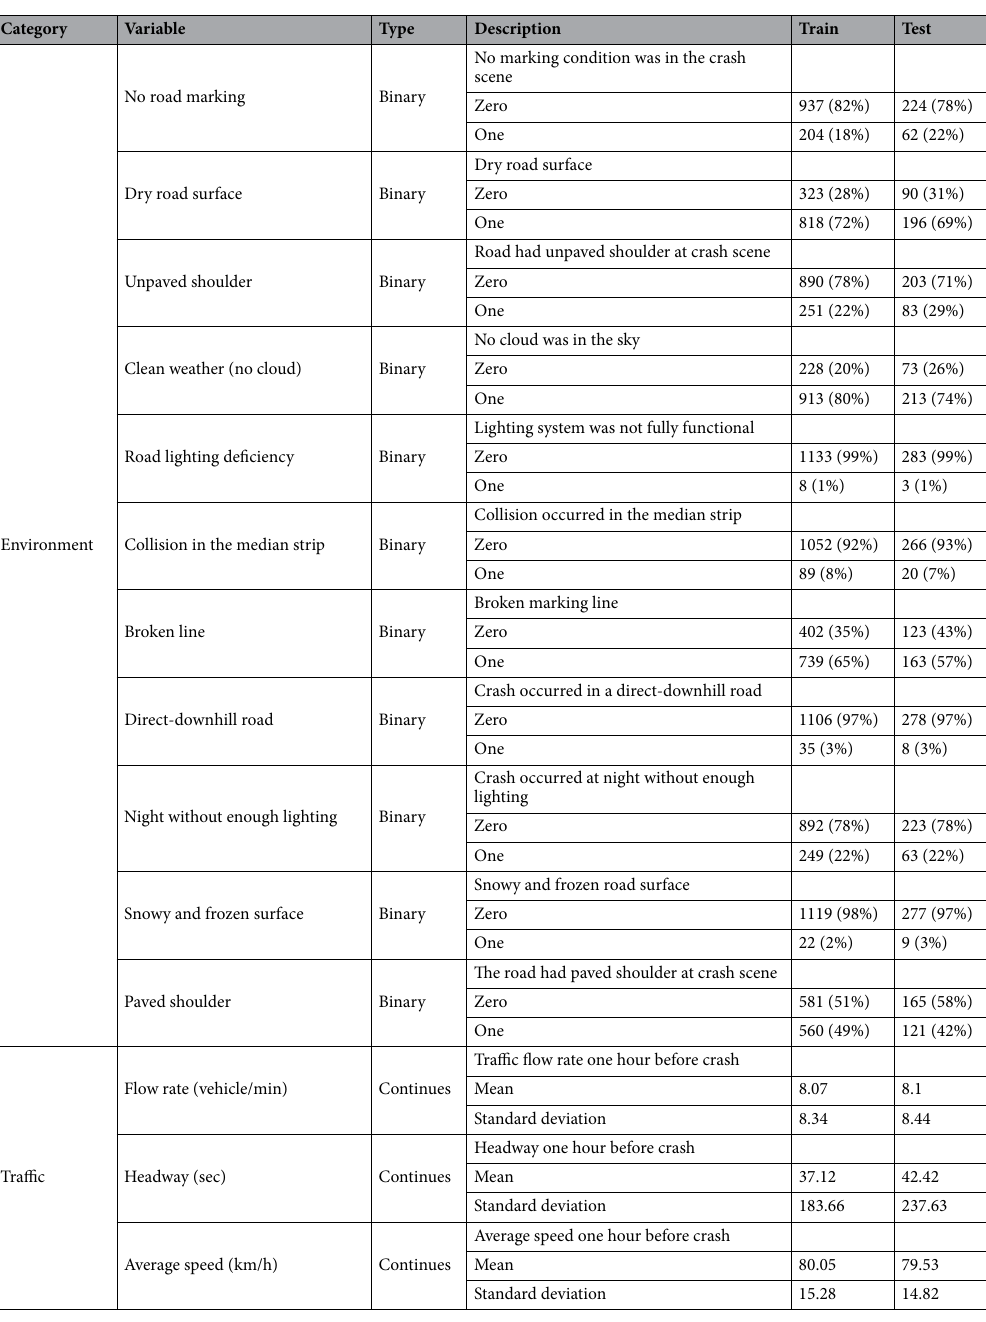
Table 2. Description of the explanatory